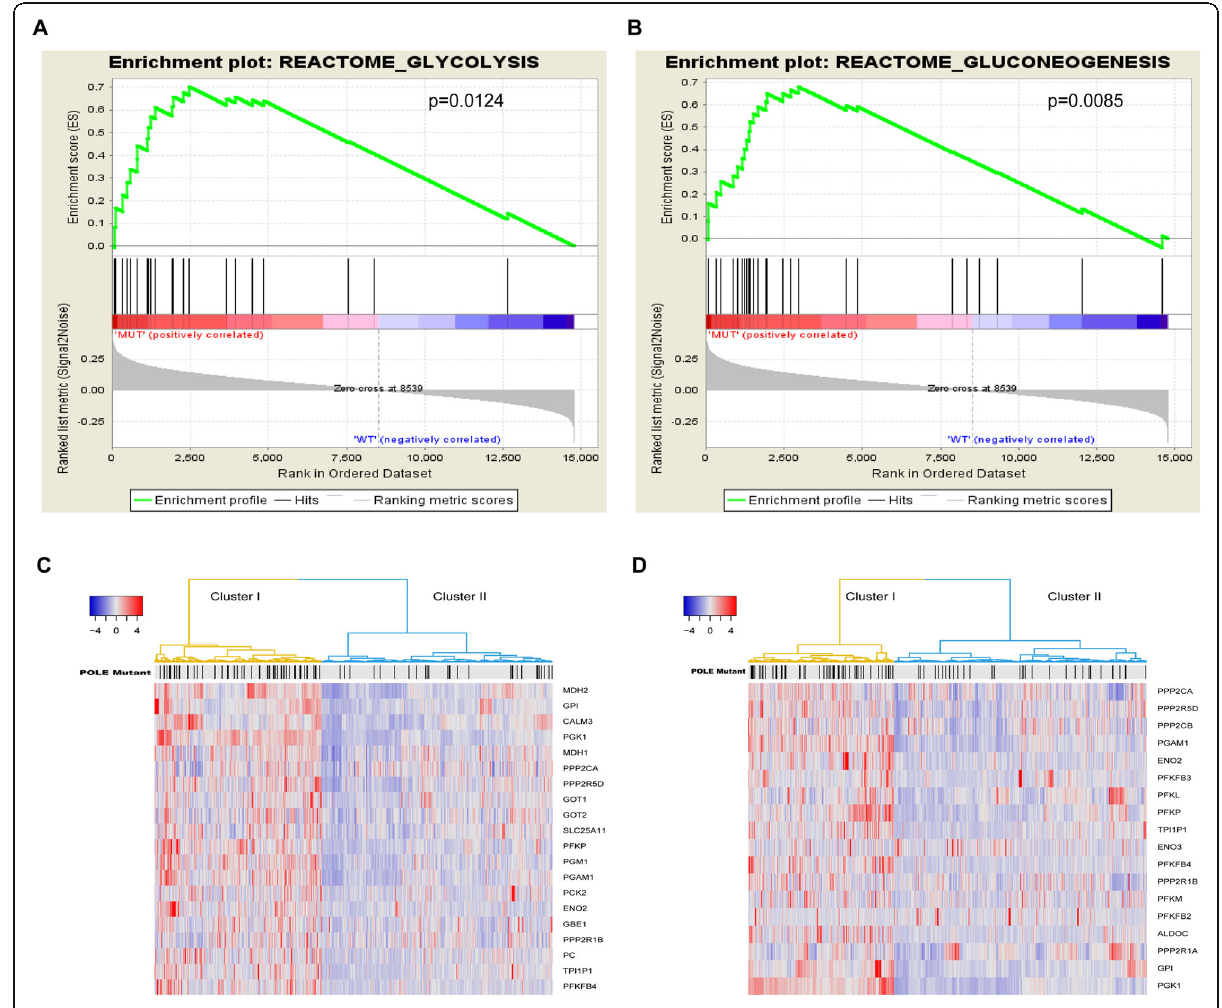
Fig. 4 Cellular glucose metabolism was enriched in POLE mutants. a , b GSEA using the canonical pathways, which are annotated pathways mainly from the KEGG, BIOCARTA and REACTOME databases, as the gene sets in the analysis. Gene sets representing glycolysis ( a ) and gluconeogenesis ( b ) were enriched in the POLE mutants. c Unsupervised hierarchical clustering with Euclidean distance and ward linkage of expression matrixes from 20 genes inglycometabolis ( d ) Unsupervised hierarchical clustering with Euclidean distance and ward linkage of expression matrixes from 18 genes in glycolysis. The POLE mutational status for each tumor is depicted directly on top of each column. The black vertical lines represent the samples with POLE mutations. Red represents high gene expression, and blue represents relatively low gene